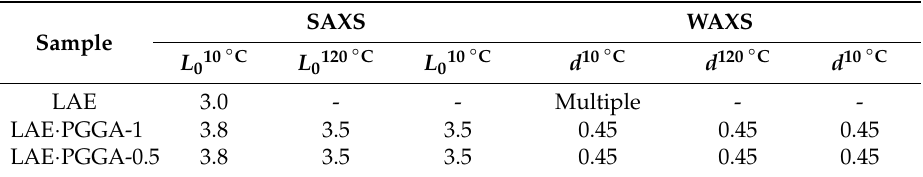
Table 3. X-ray diffraction data of LAE · PGGA